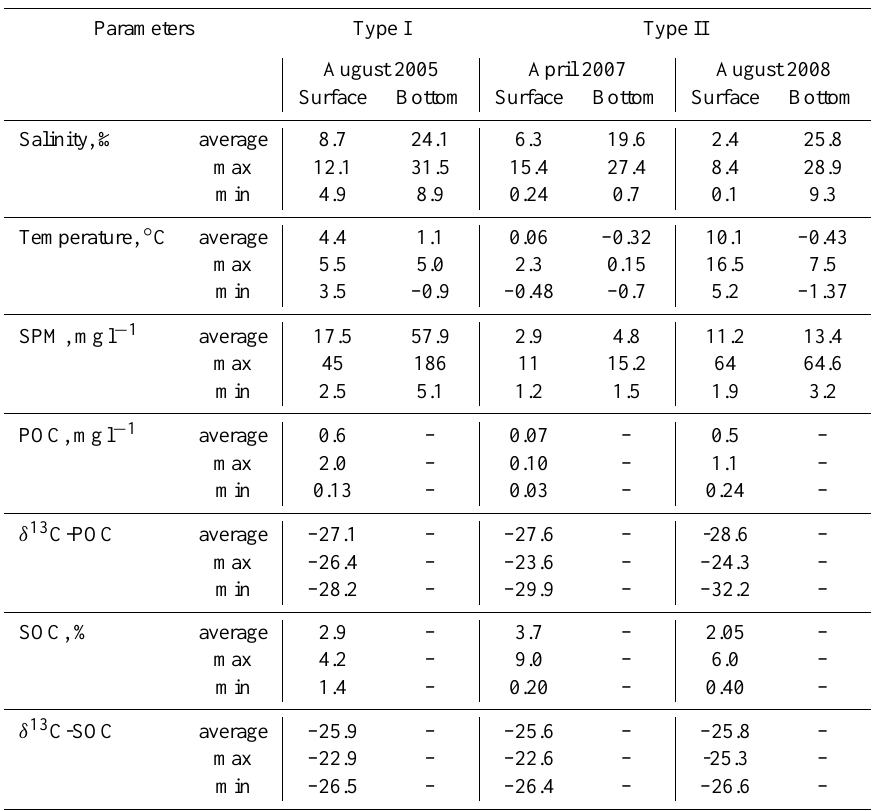
Table 3. Temporal variability of core hydrological and sedimentation parameters for water column and bottom sediments under different types of sedimentation regime.